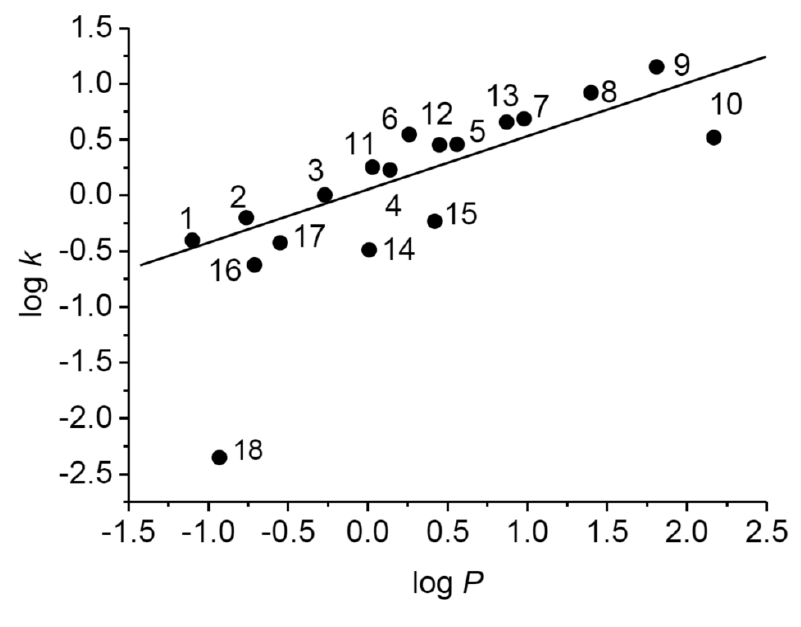
Figure 1. Dependence of experimentally determined log k on calculated log P values of tested